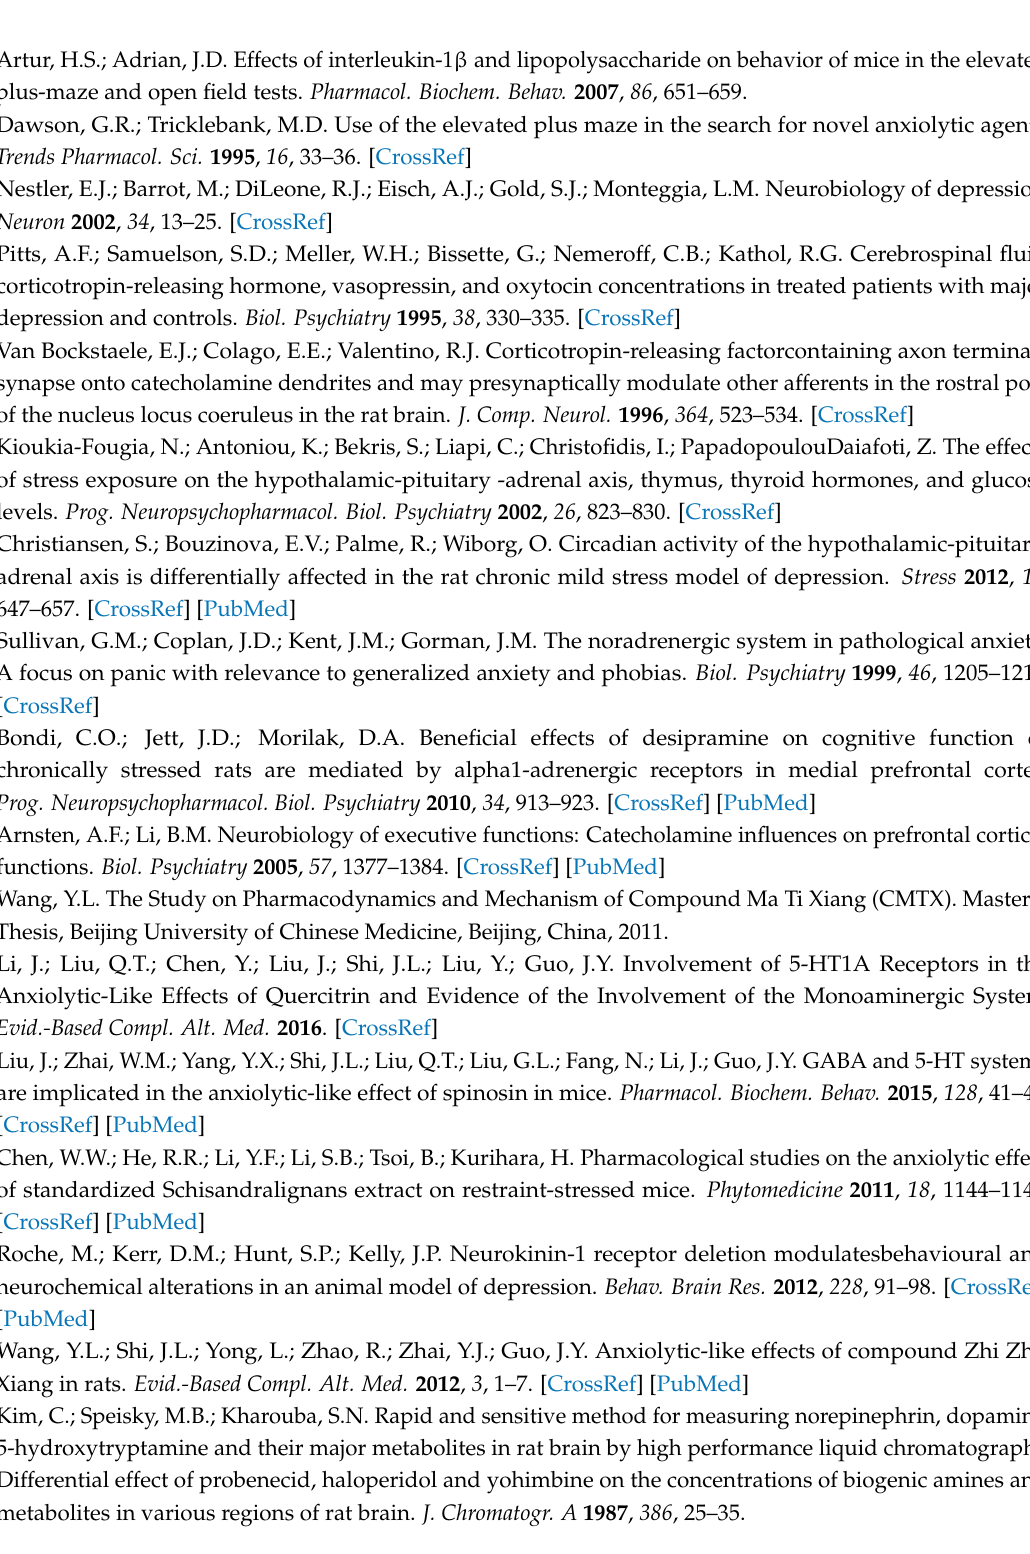
Sample Availability: Samples of the SAG (( − )-syringaresnol-4- O - β - D -apiofuranosyl-(1 → 2)- β - D -glucopyranoside) are available from the